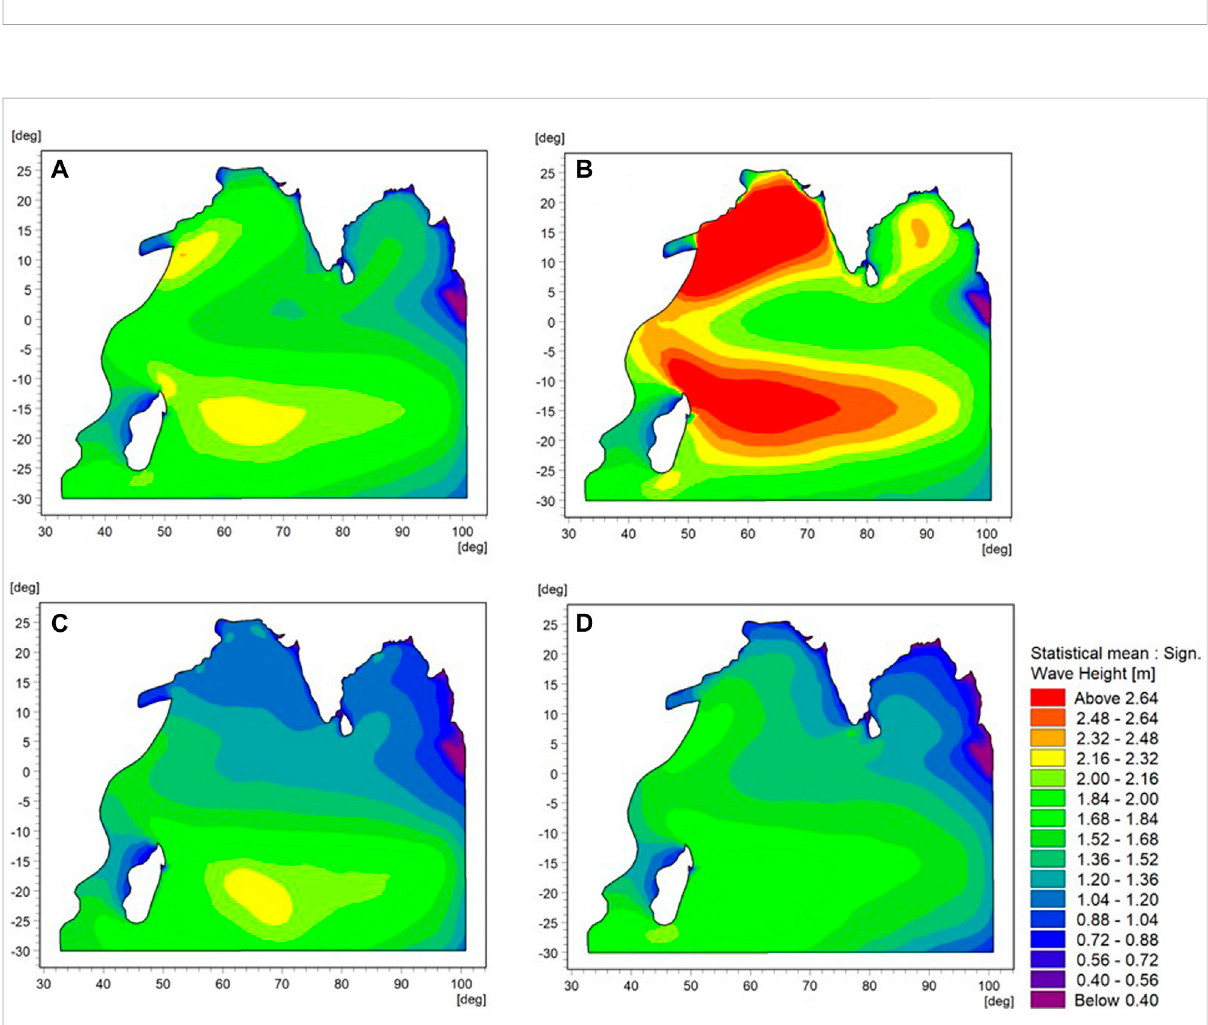
FIGURE 7 Spatial distribution of Signi fi cant wave height (Hs) based on wave data for the year 2019 (A) Annual mean (B) Monsoon mean (C) Pre monsoon mean (D) Post monsoon mean.